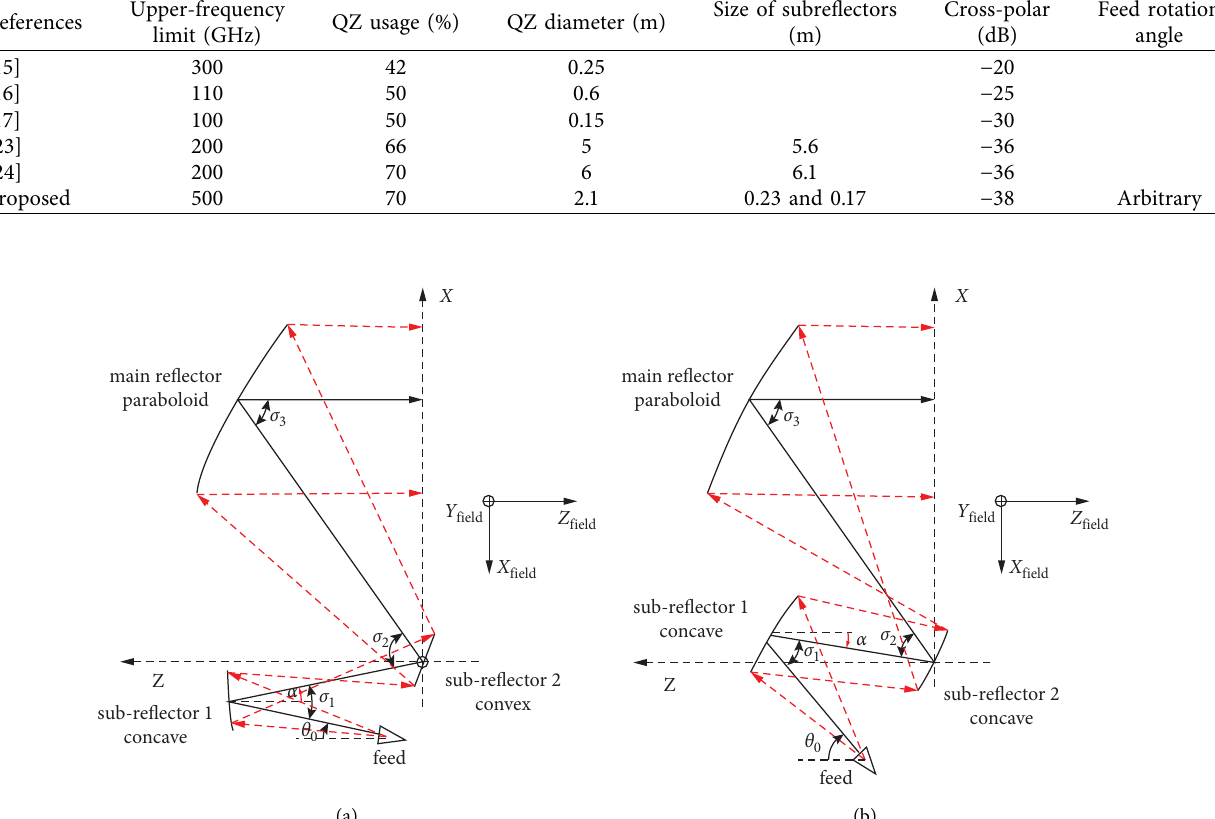
Table 1: Comparison between the proposed tri-refector CATR system and the reported CATR